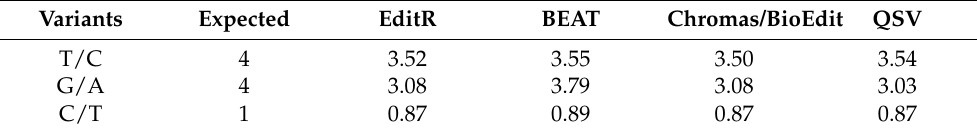
Table 3. Estimating copy-number proportions of the bovine gene CD32 based on Sanger sequencing 1